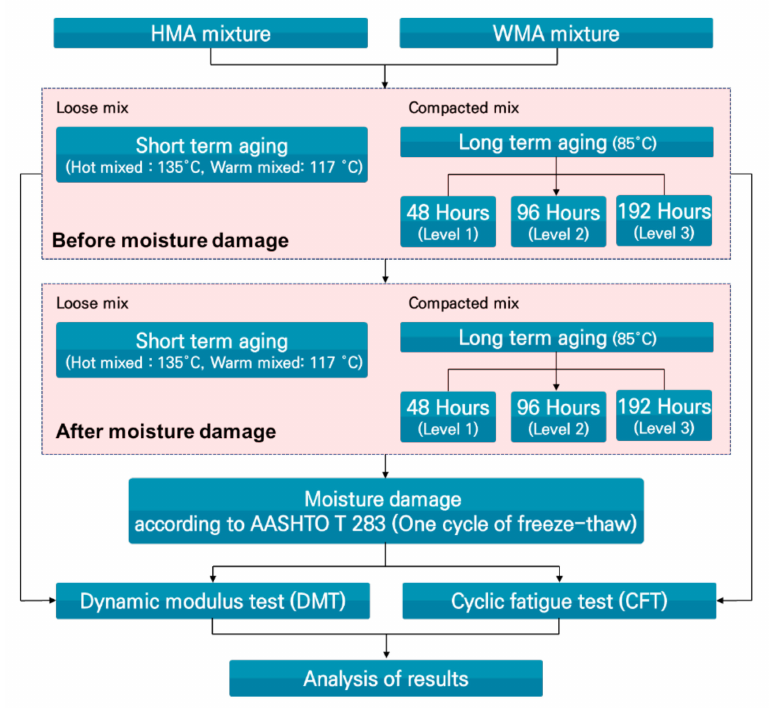
Figure 4. Flowchart of the